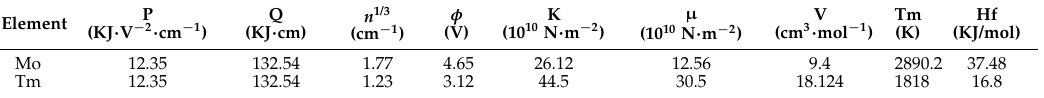
Figure 5. Gibbs free energy of the Mo-Tm system vs. molybdenum content. ∆ G s and ∆ G a are the Gibbs free energy of the crystalline solid solution and amorphization, respectively. Table 1. Thermodynamics parameters for calculation [27,28].